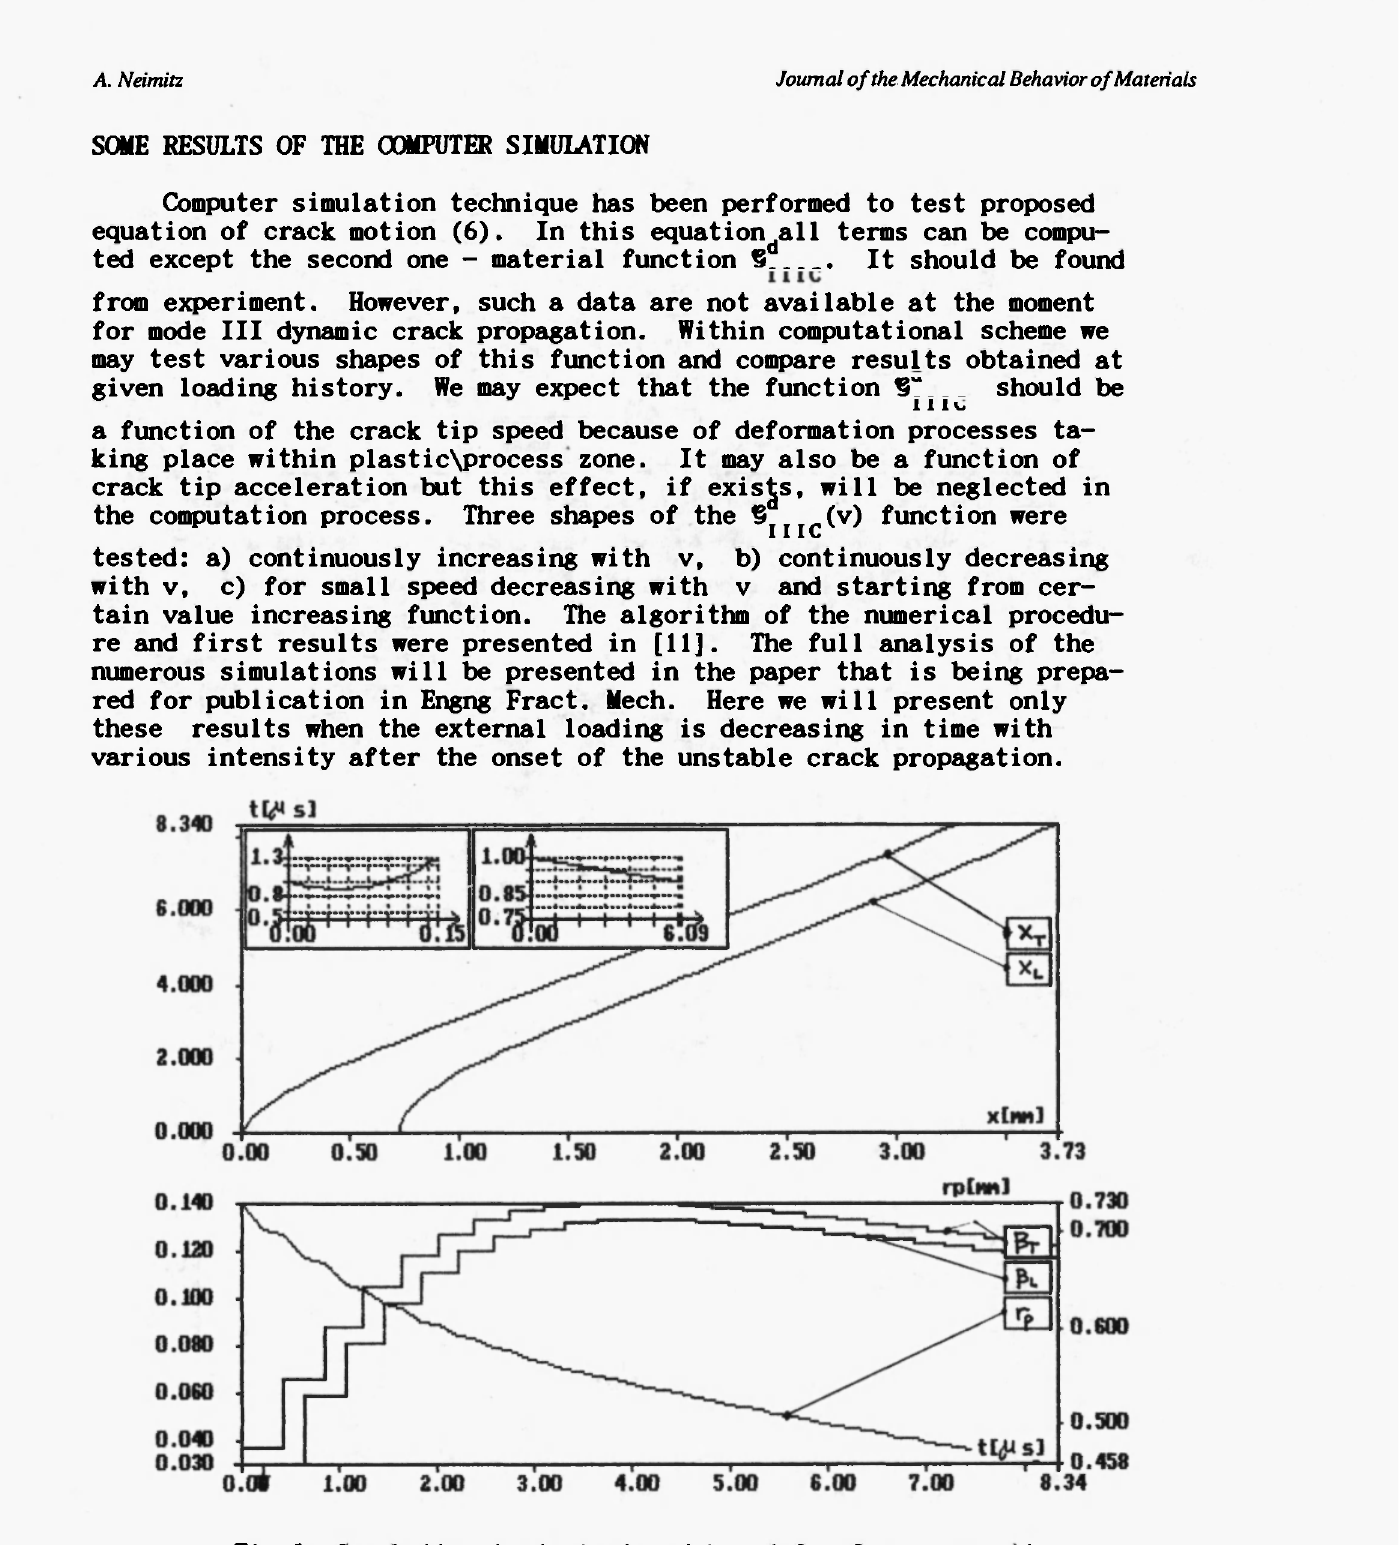
Fig.3. Crack tips trajectories (a) and 0. β. τ vs. time Τ L ρ plots (b^. External loading decreasing (slope 10 per cent). Sj function of type IIC